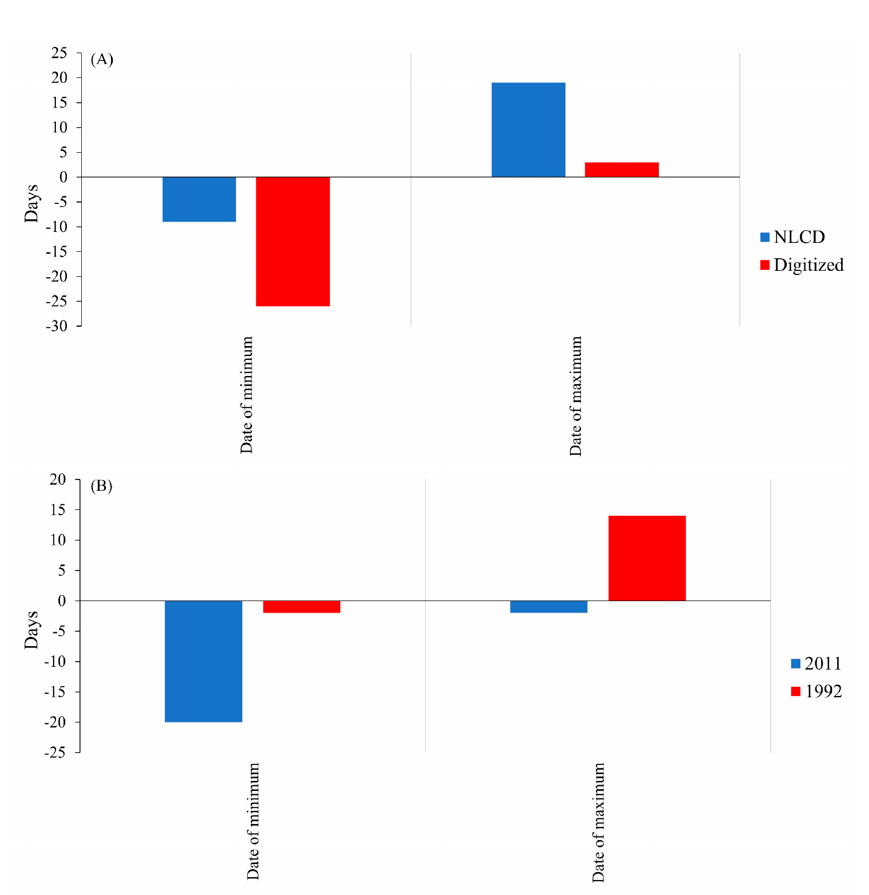
Figure 7. Changes in the timing of annual extreme flows due to the source of LULC data ( A ) and due to the temporal condition of LULC distribution in the watershed using 1992 and 2011 LULC data ( B ). Rate of extreme flows: The NLCD datasets led to markedly lower percent differences in the simulated rise and fall rates (21 and 5% differences, respectively) compared to the Digitized LULC datasets (40 and 23% differences) (Figure 8A). The 1992 datasets led to smaller percent differences in the predicted rise and fall rates, with a deviation of 7 and